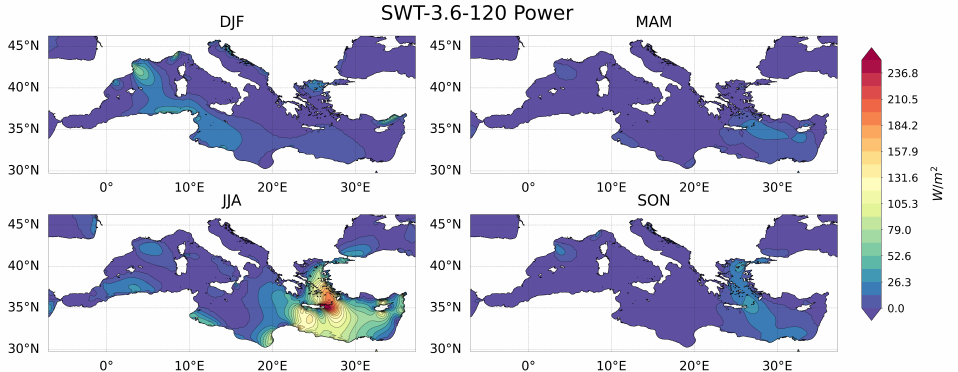
Figure 13. Seasonally averaged calculated power generation using a SWT-3.6-120 industrial turbine with height corrected wind speed data (with Equation (2)) from the WRF/ORCHIDEE 10 m wind speed